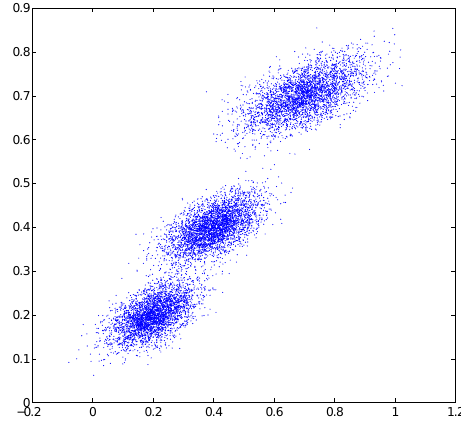
Figure 8. Data distribution with 3-components Gaussian mixtures.